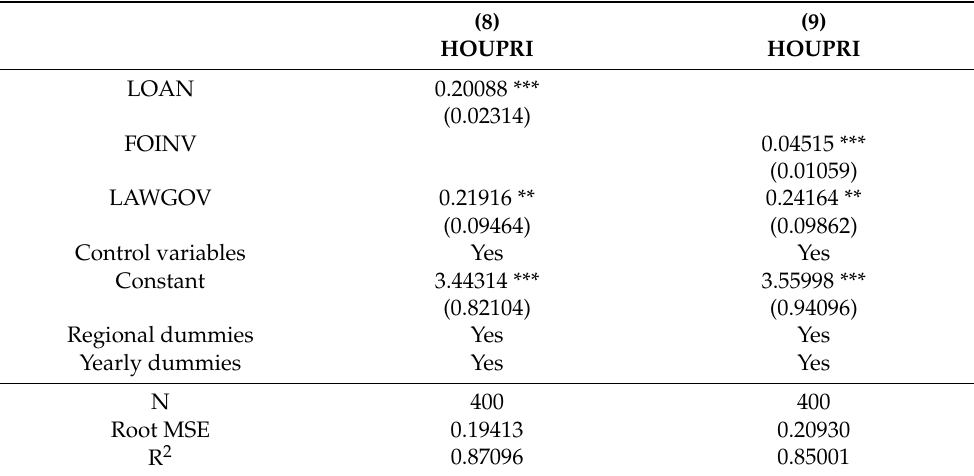
Table 6. Correlation between financial loans and housing prices, and correlation between foreign investment and housing